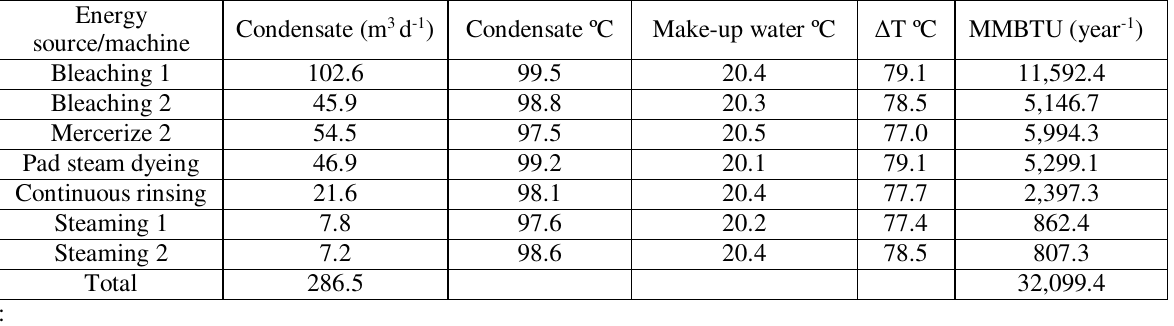
Table 7: Assessment of recovered heat energy from steam condensate